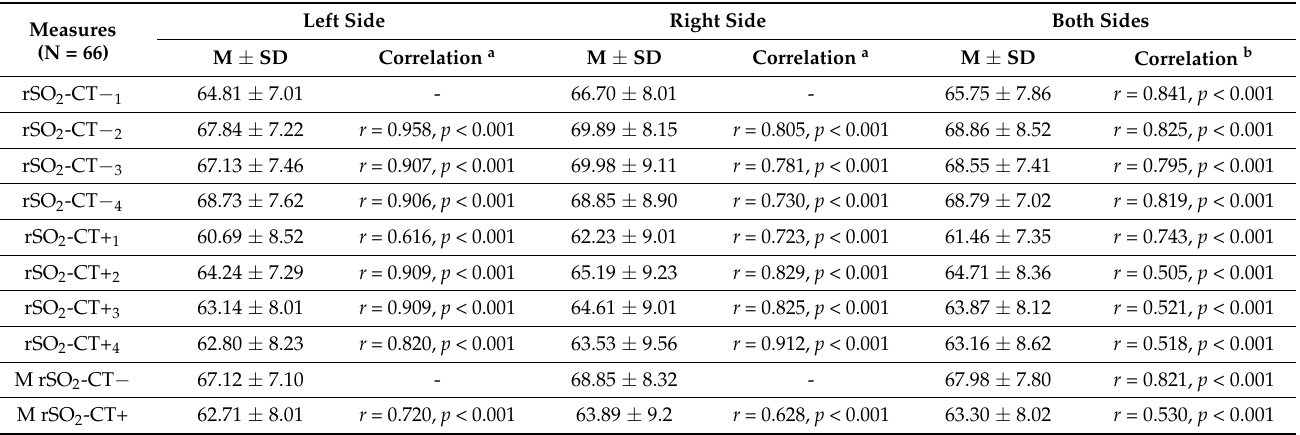
Figure 3. Relationship between number of CT cycles, PVF, and SVF. Something similar occurred with the average of the rSO 2 (Table 5), which clearly correlated with a significant decrease in PVF ( r = 0.535, p < 0.001) and SVF ( r = 0.485, p < 0.001) in CT+. Additionally, the CT+ group showed a significant decrease in rSO 2 ( p < 0.001) with respect to the rest of the treatments. Evolution of rSO 2 measures is shown in Table 6. The means on the left, the right, and both sides as well as the correlation between measures are shown on columns of the table. Finally, the last two rows show the means of the three measures in CT+ and CT − groups. Table 6. Evolution of rSO 2